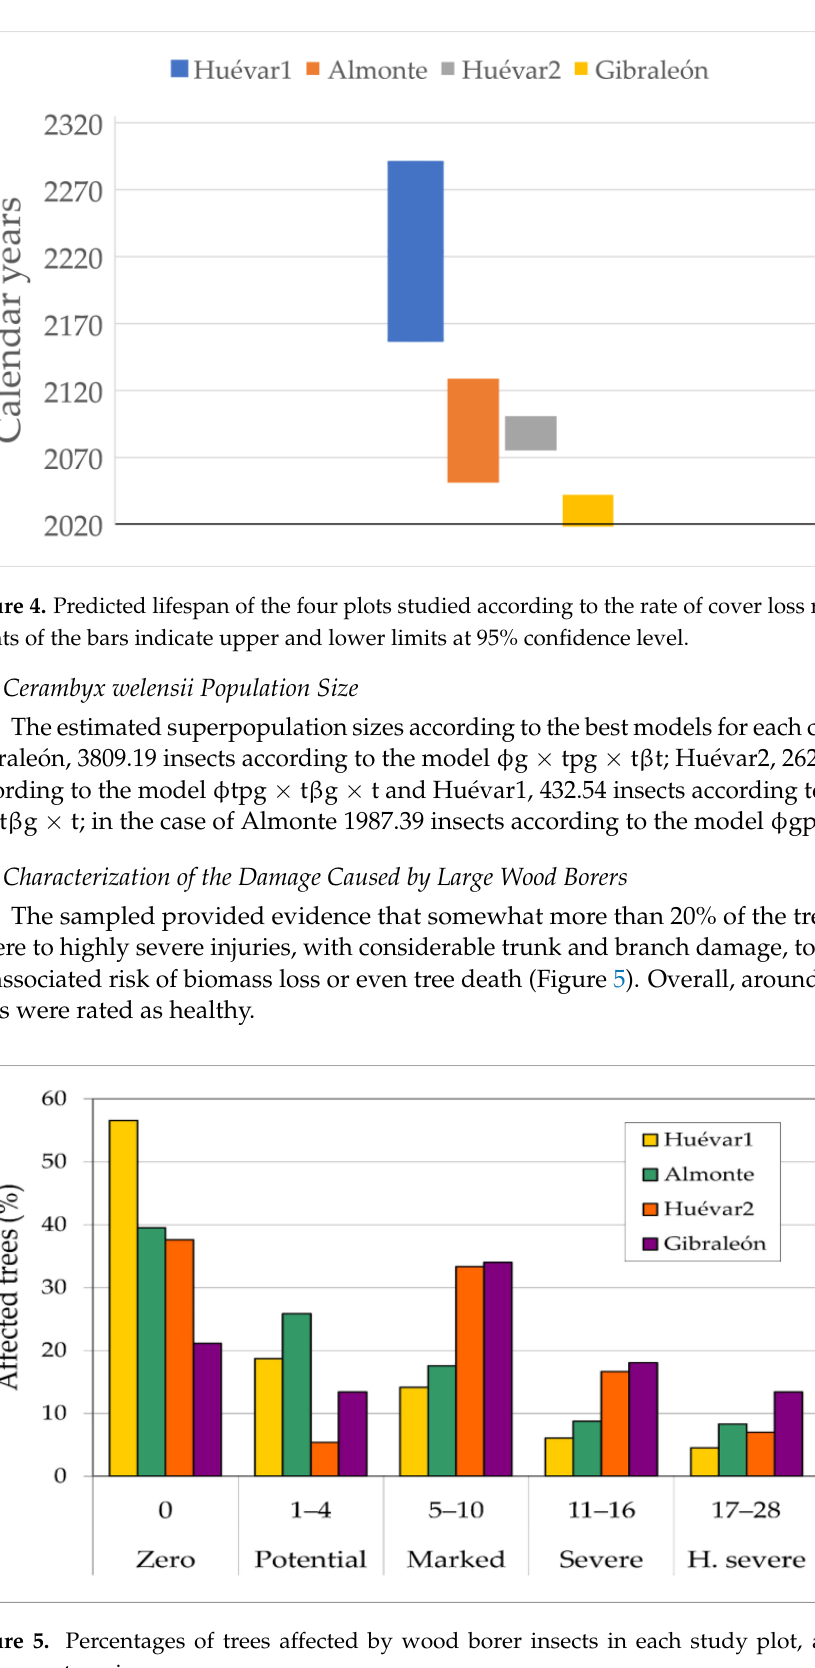
Figure 6. Linear relationship between wood borer population size and degree of severe damage to trees. Specifically, the largest wood borer superpopulation observed corresponded to stands in which 31.4% of the trees showed severe or highly severe wood borer damage, with an average canopy cover loss of 1.68% a year, indicating a short-term risk of com- pletely losing the forest cover (10 – 30 years). Further, an intermediate population size was found in stands where 17.01 – 23.6% of the all the trees studied manifested severe or very severe symptoms of infestation, with an annual average canopy cover loss of 1.13%, im- plying a risk of disappearance of the entire forest cover in the relative short term (45 – 90 years). Lastly, the lowest population size detected corresponded to forest stands with 10.6% of the trees showing severe or highly severe injuries, with a yearly average canopy cover loss of 0.42%, suggesting a long term risk of the entire forest cover disappearing in the long term (100 – 260 years). 4. Discussion The rate of dehesa decline which took place during the period of intensive reduction (1957 – 1984) positioned the area of study slightly above the highest figures from other re- gions of the autonomous community of Andalusia, such as the Sierra Morena (24%, [3]) or the Sierra Norte (20 – 25%, [2]). The overall loss has also continued up to the present day, although with a deceleration to that occurring in other geographical scenarios ([48], citing Miguel et al. [49]). In general, this loss of dehesa corresponded to a change in activity from